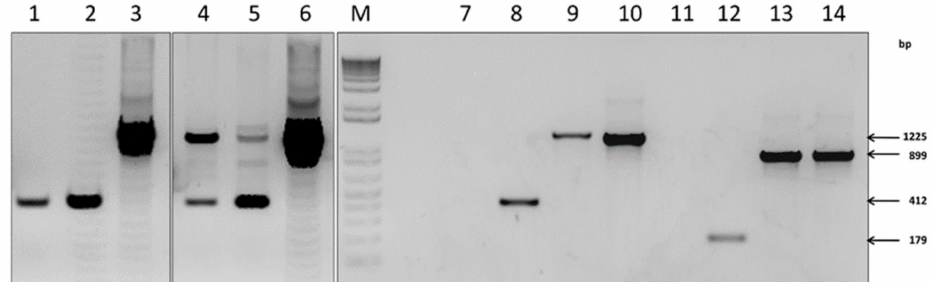
Figure 3. Verification of insertions by PCR. M—1 Kb Plus DNA Ladder (Invitrogen, USA). Lanes 1–10 contain DNA fragments amplified from the TK gene and 11–14 from RR gene; 1, 2—total DNA from LT cells of first selective passage of viruses; 4, 5—total DNA from LT cells of second passage of viruses after selective pressure removal; 7, 11—total DNA of healthy LT cells (control-mock); 8, 12—total DNA from LT cells infected with SPPV NISKhI; 9, 13—total DNA from LT cells infected with the rSPPV(TK-)EGFP and rSPPV(RR-)EGFP, respectively; 3, 6, 10—pIN-TK-EGFP and